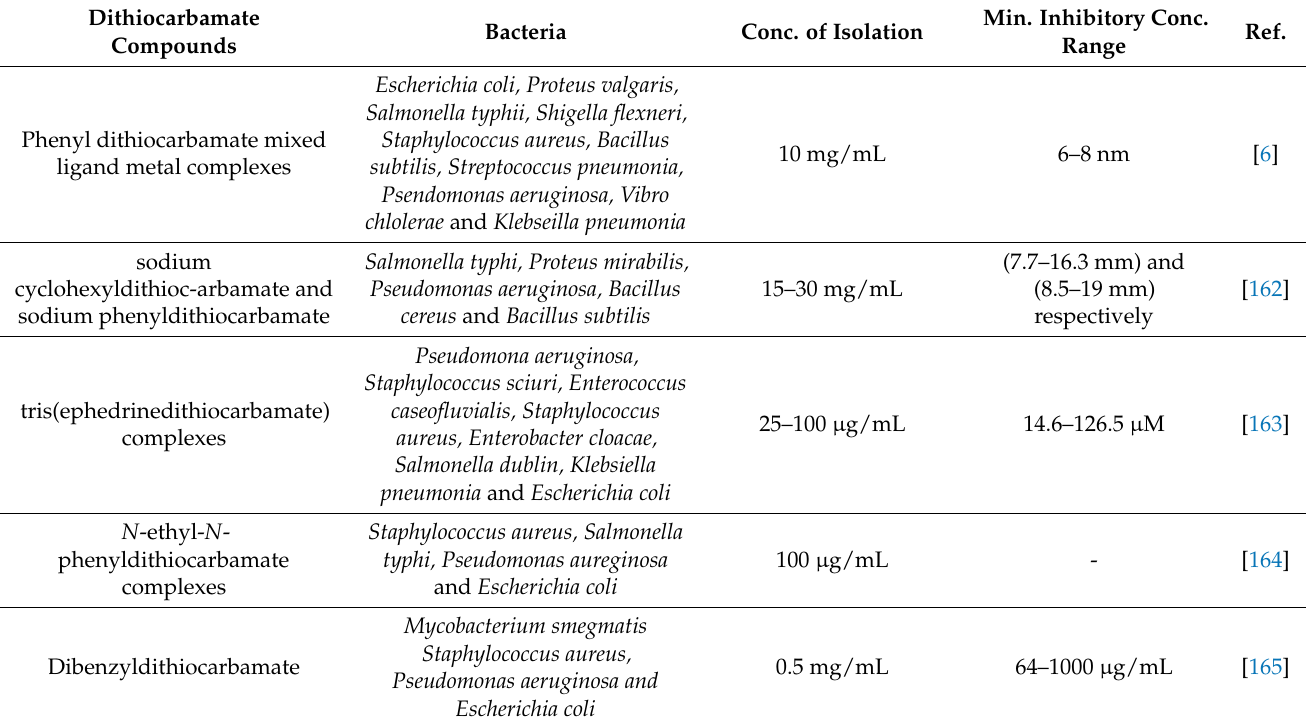
Table 6. Specific examples of antibacterial properties of dithiocarbamates against some bacte- rial